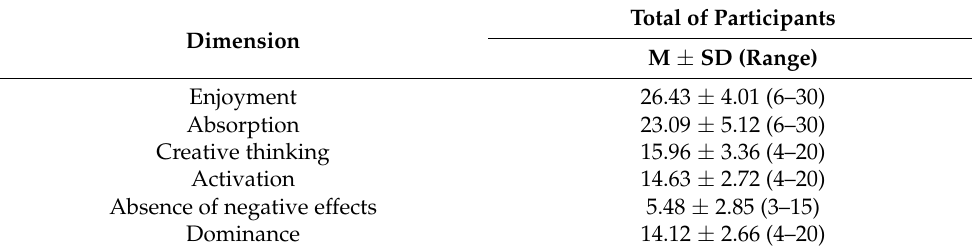
Table 2. GAMEX dimension: mean and standard deviation of total of participants.